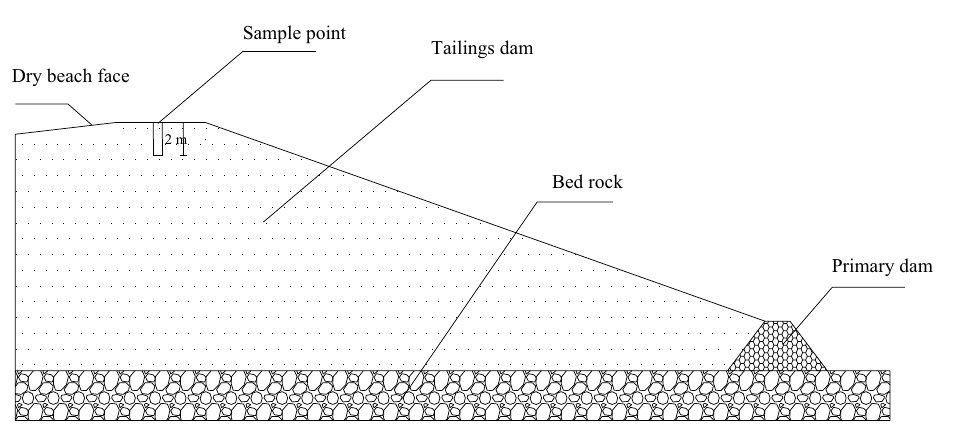
Figure 1. Site location and root system of tailing ponds in the study area. ( a ) Google Earth image snippets of the area (https:// www. google. com/ earth/) also show the location of the study area in Liaoning Province, China. ( b ) The topography map of Wai tou Mountain in Xi hu District, prepared by Qing chao Yang using ArcGIS ver. 10.8 (https:// www. esri. com/), is based on the elevation data downloaded from the Geospatial Data Cloud (https:// www. gsclo ud. cn/ search). ( c ) The root images of A. fruticosa at sampling sites were recorded by camera.